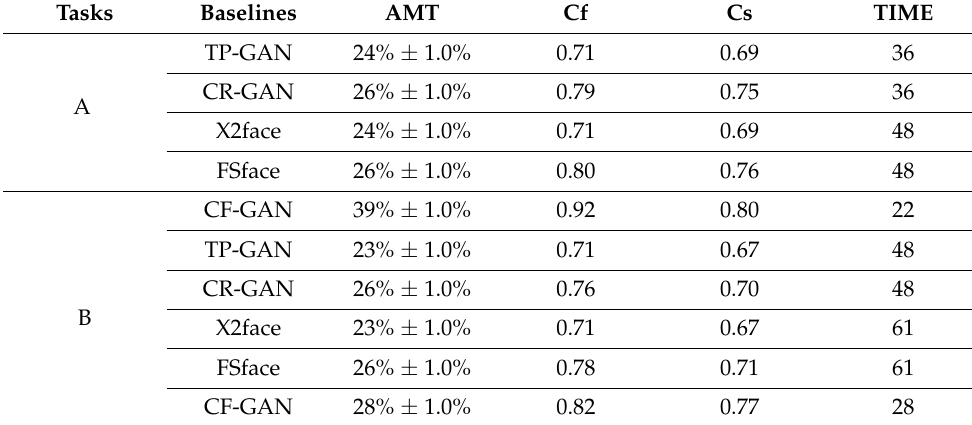
Table 1. Quantitative evaluations in terms of facial pose and anger expression transfer (A for short), facial pose, and happy expression transfer (B for short) tasks from different